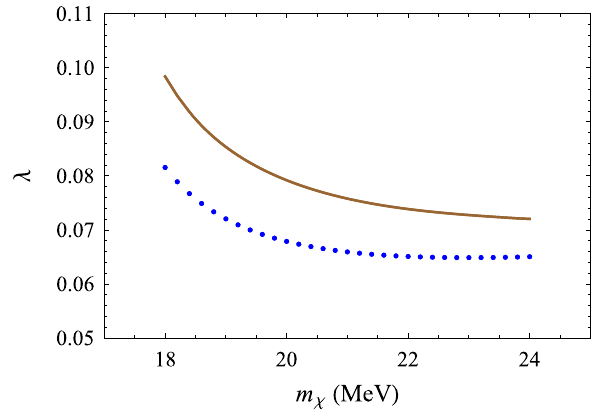
Fig. 1 The value of λ for fermionic millicharged DM with the f DM required by the EDGES observation. Here m A = 17 MeV is taken, and the mass range of millicharged DM 18 (cid:3) m χ (cid:3) 24 MeV is considered. The dotted and solid curves are for the cases of f DM = 0 . 4% and m χ (MeV)/10 × 0.115%, respectively